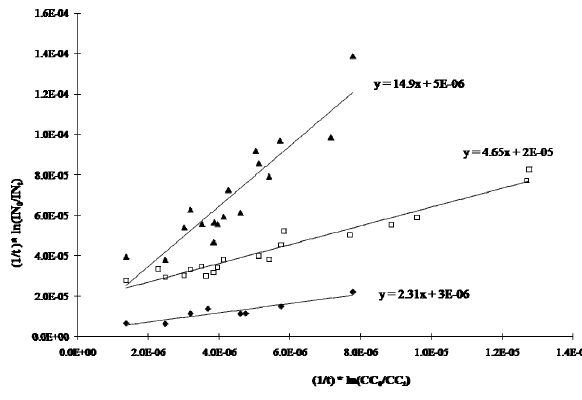
Fig. 8. Ozone rate constant data for three isoprene nitrate isomers. Figure 8. Ozone rate constant data for three isoprene nitrate isomers. Triangles = (2,1)-IN, Triangles=(2,1)-IN, squares=(1,2)-IN, and squares = (1,2)-IN, and diamonds = E-(1,4)-IN.